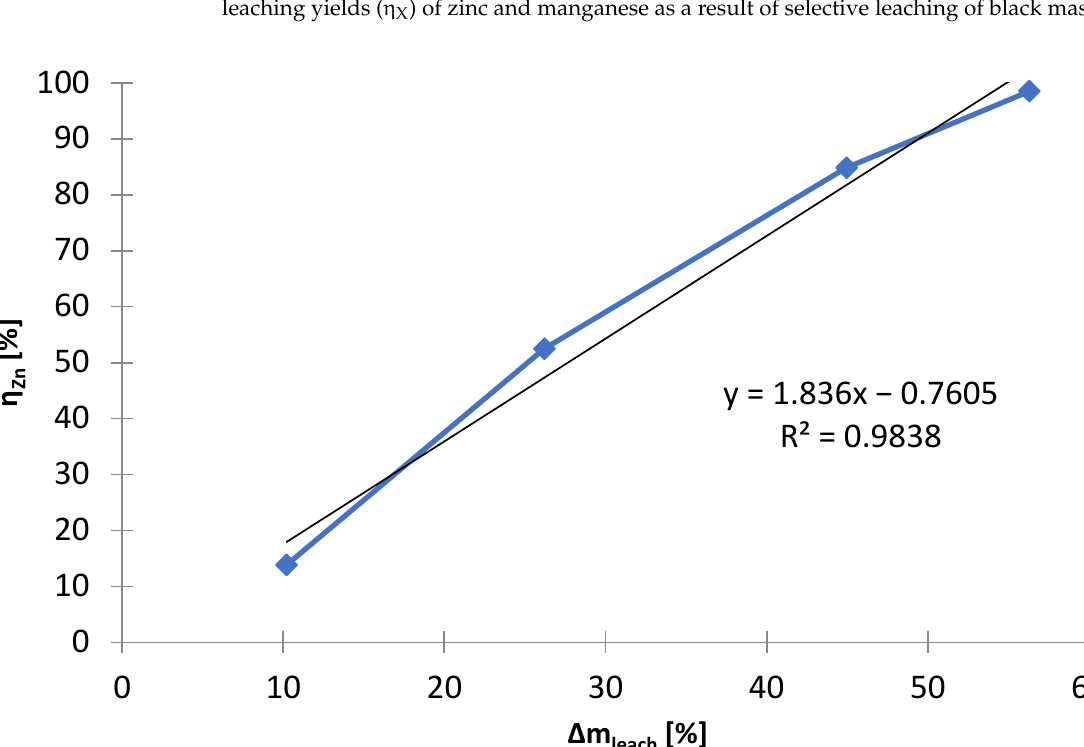
Figure 6. Relationship between ∆ m leach and η Zn ; selective leaching of black mass .